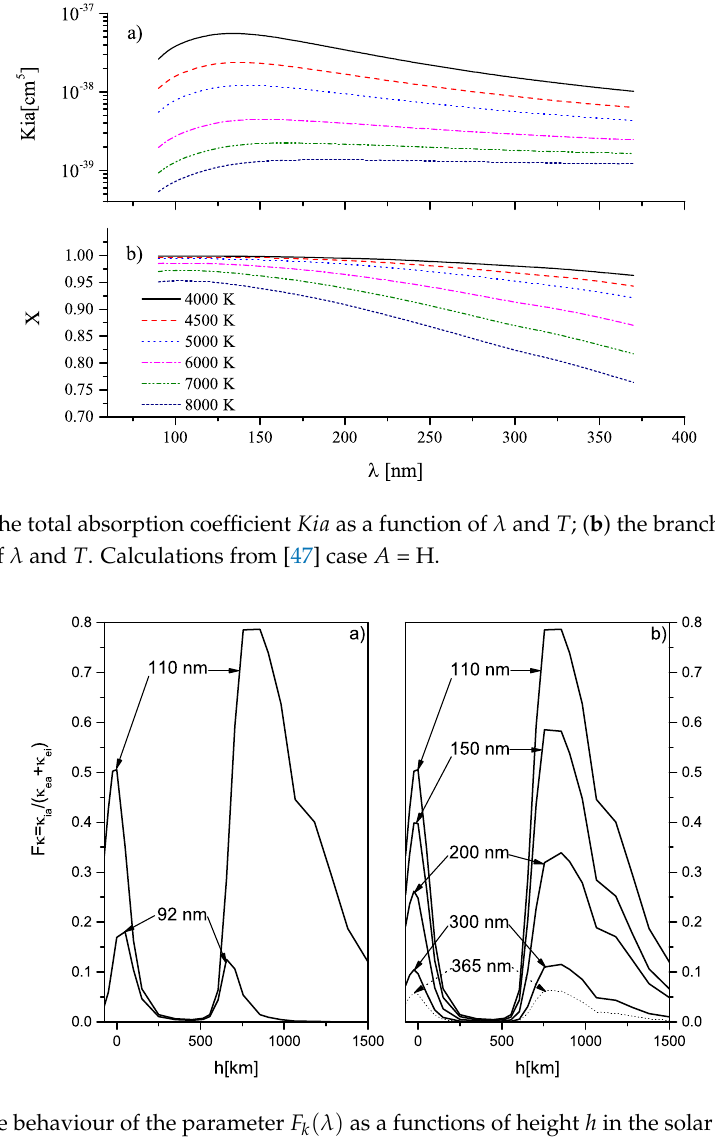
Figure 16. The behaviour of the parameter F k ( λ ) as a functions of height h in the solar